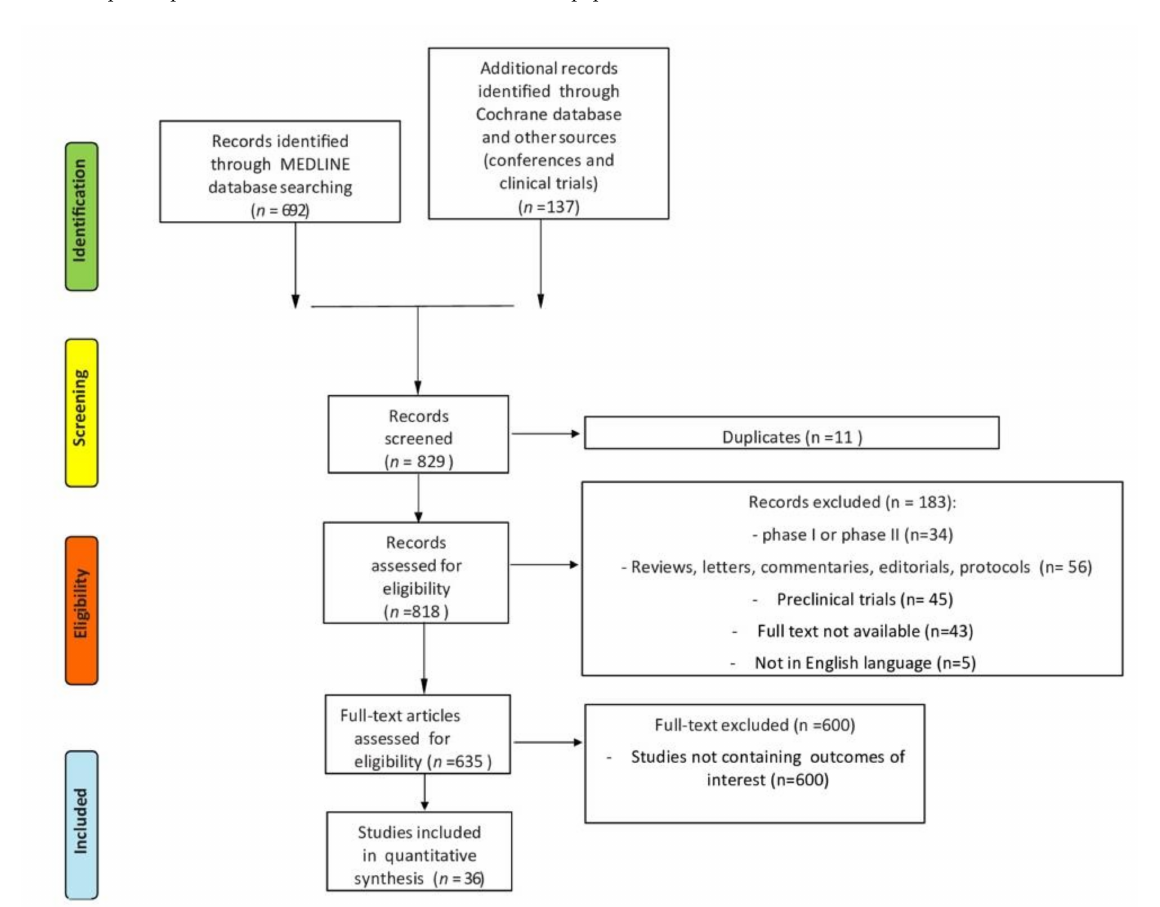
Figure 1. Preferred reporting items for systematic reviews and meta-analyses (PRISMA) flowchart